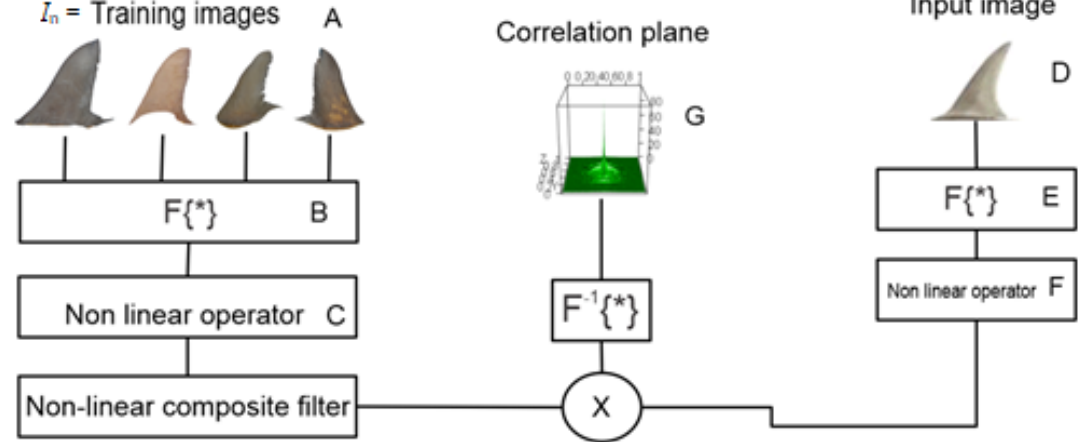
Figure 3. Steps to obtain the non-linear composite filter.